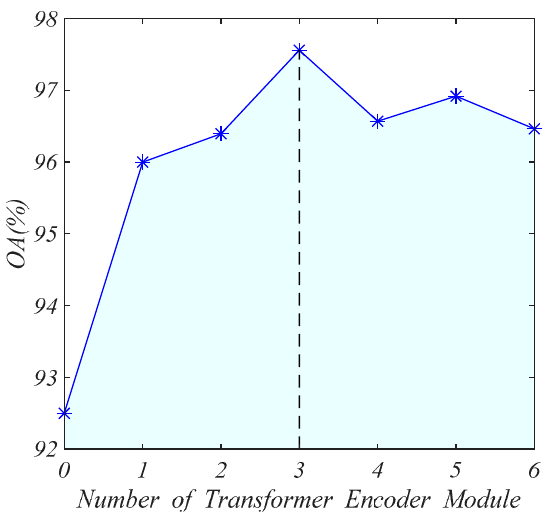
Figure 16. The influence of the number of transformer encoder modules.